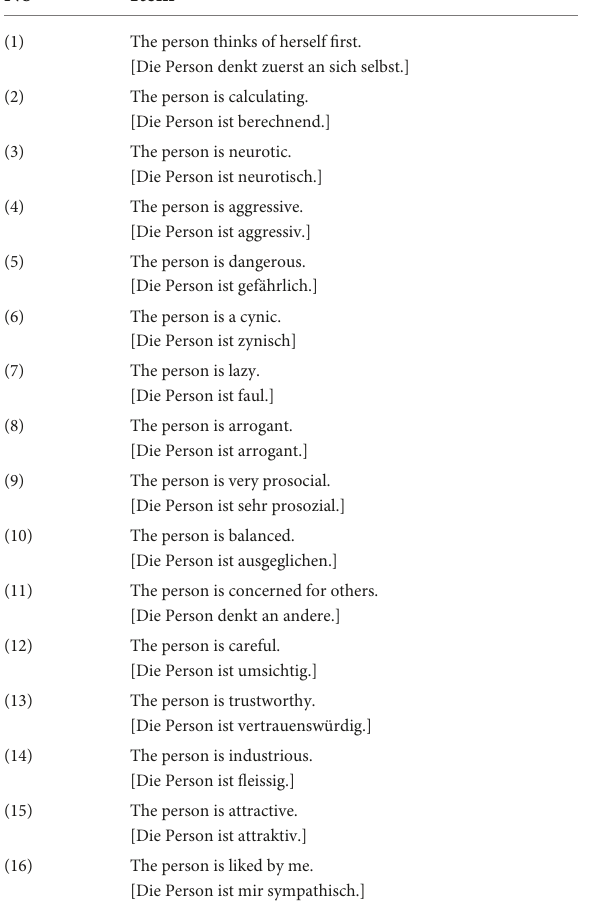
TABLE 4 Items measuring how the participant perceives the target